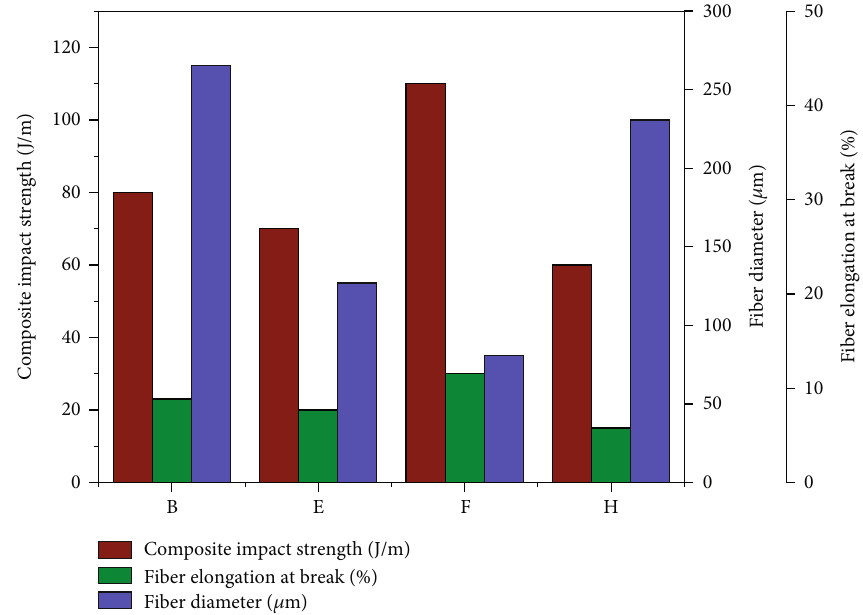
Figure 8: Fiber elongation at break and fi ber diameter have an impact on composite impact